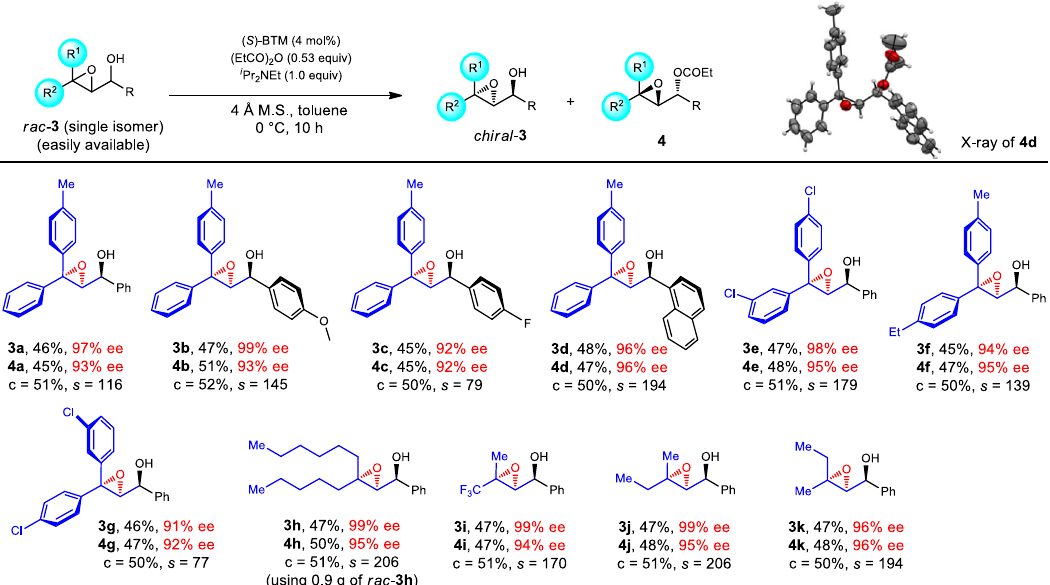
Fig. 3 Scope of epoxides with similar geminal substituents. 3a – 3g , resolution of epoxides with two similar aromatic substituents. 3h – 3k , resolution of epoxides with two similar aliphatic substituents. c